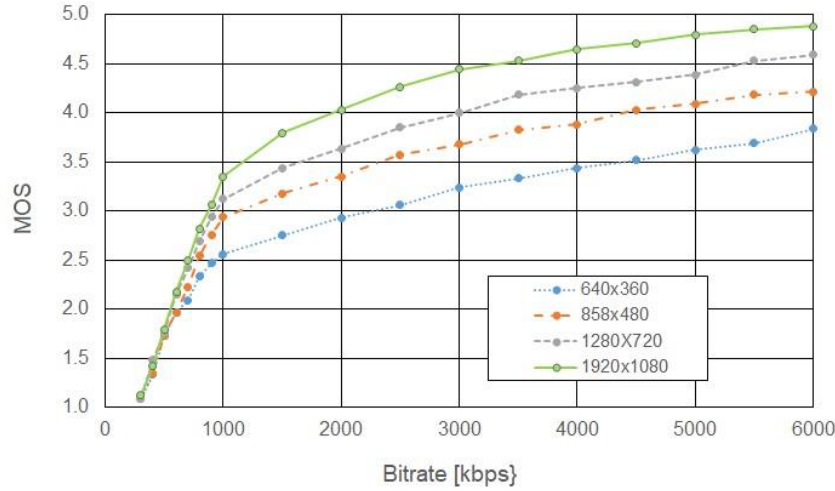
Figure 8. Results of the subjective quality assessment (MOS) for the H.265-encoded video as a function of bit rate for different spatial resolutions—measurements at home. Table 5. Mean value of the video quality assessment (MOS) for H.265 codec, standard deviation (S), and confidence interval coefficient ( δ ) for four resolutions—measurements in